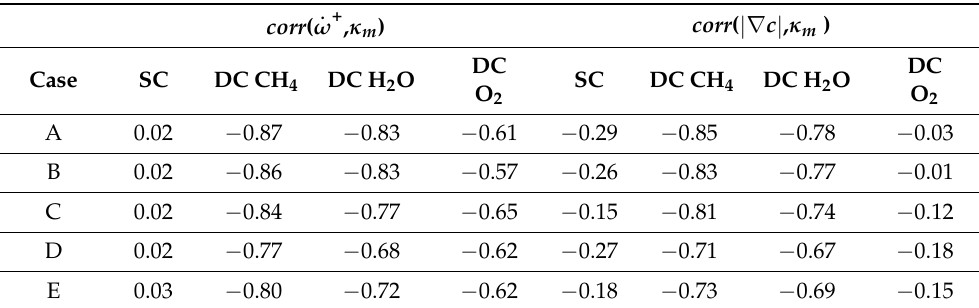
Figure 18. Joint PDF of normalised SDF |∇ c | × δ L and normalised mean curvature κ m × δ L on c = 0.8 progress-variable isosurface for top to bottom cases A–E for (1st column) SC and (2nd to 4th column) DC simulations for reaction progress variable based on CH 4 , H 2 O,O 2 mass fractions. . + Table 12. Correlation coefficients between ω and |∇ c | with κ m for the c = 0.8 isosurface value for all